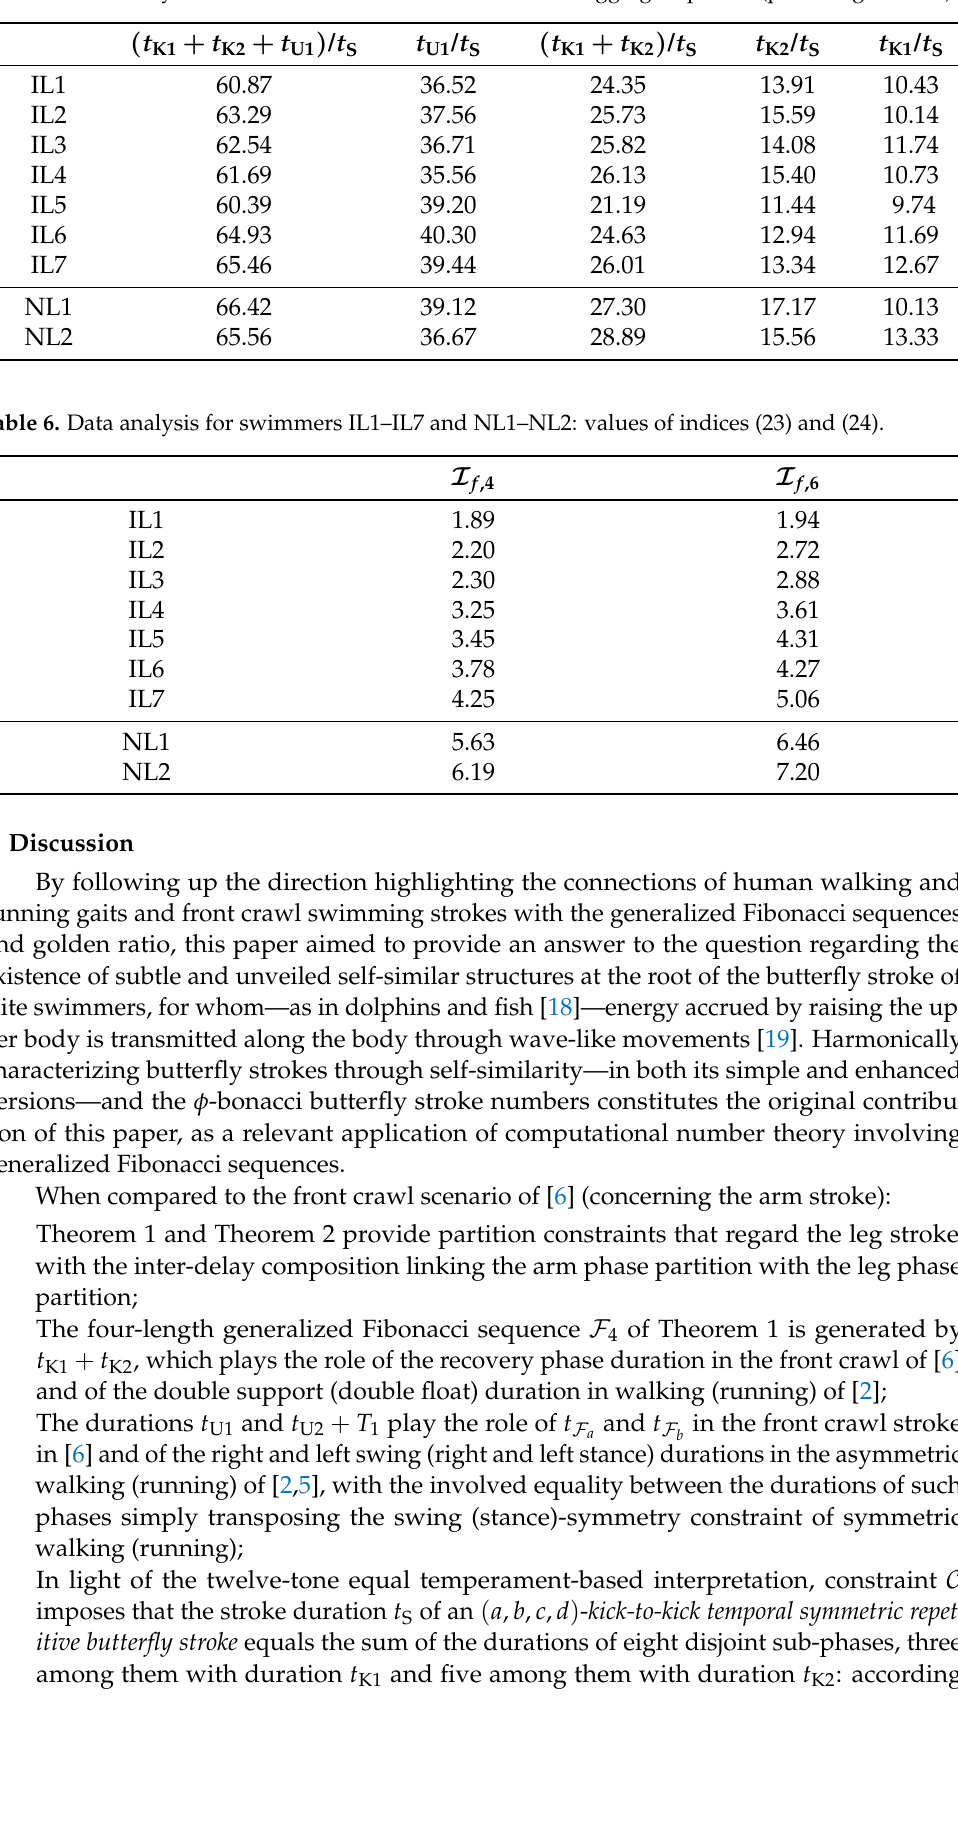
Table 5. Data analysis for swimmers IL1–IL7 and NL1–NL2: aggregate phases (percentage values).